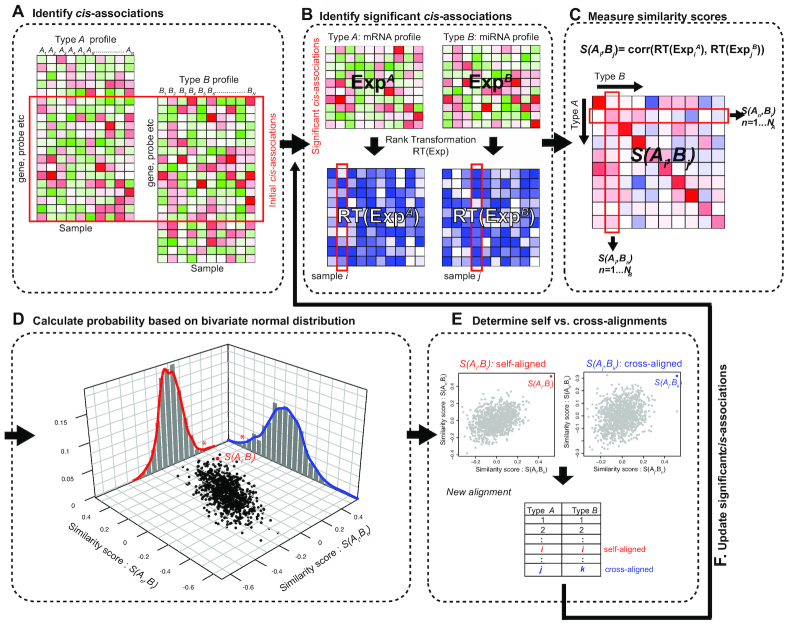
Overview of proMODMatcher procedure. (A) Probes in 2 types of profiles (i.e., Type A and Type B) were matched by intrinsic biological relationships. (B) The significant cis-associations from 2 different data types were identified by the Spearman correlation. The data for each cis relationship were normal rank-transformed. (C) The sample similarity score between the 2 types of data \documentclass[12pt]{minimal}
\usepackage{amsmath}
\usepackage{wasysym}
\usepackage{amsfonts}
\usepackage{amssymb}
\usepackage{amsbsy}
\usepackage{upgreek}
\usepackage{mathrsfs}
\setlength{\oddsidemargin}{-69pt}
\begin{document}
}{}$S( {{A_i},\ {B_j}} )$\end{document} is defined as the Spearman correlation between normal rank-transformed profiles. (D) The proMODMatcher evaluated the similarity score of a match, \documentclass[12pt]{minimal}
\usepackage{amsmath}
\usepackage{wasysym}
\usepackage{amsfonts}
\usepackage{amssymb}
\usepackage{amsbsy}
\usepackage{upgreek}
\usepackage{mathrsfs}
\setlength{\oddsidemargin}{-69pt}
\begin{document}
}{}$\ S( {{A_i},\ {B_j}} )$\end{document}, by calculating the probability of a match estimated on the basis of a score distribution of \documentclass[12pt]{minimal}
\usepackage{amsmath}
\usepackage{wasysym}
\usepackage{amsfonts}
\usepackage{amssymb}
\usepackage{amsbsy}
\usepackage{upgreek}
\usepackage{mathrsfs}
\setlength{\oddsidemargin}{-69pt}
\begin{document}
}{}$\ ( {S( {{A_i},\ {B_n}} ),\ S( {{A_n},\ {B_j}} )} )$\end{document}, where An and Bn represent Type A and Type B profile of the nth matched profile pairs. (E) In the determine self-aligned vs cross-aligned step, profile pairs matched by sample IDs were checked to determine whether their similarity scores were high, in which case they would be annotated as “self-aligned.” If not, additional steps were applied to find any potential matches among other unmatched profiles. The matched profile pairs were used to update significant cis-associations.